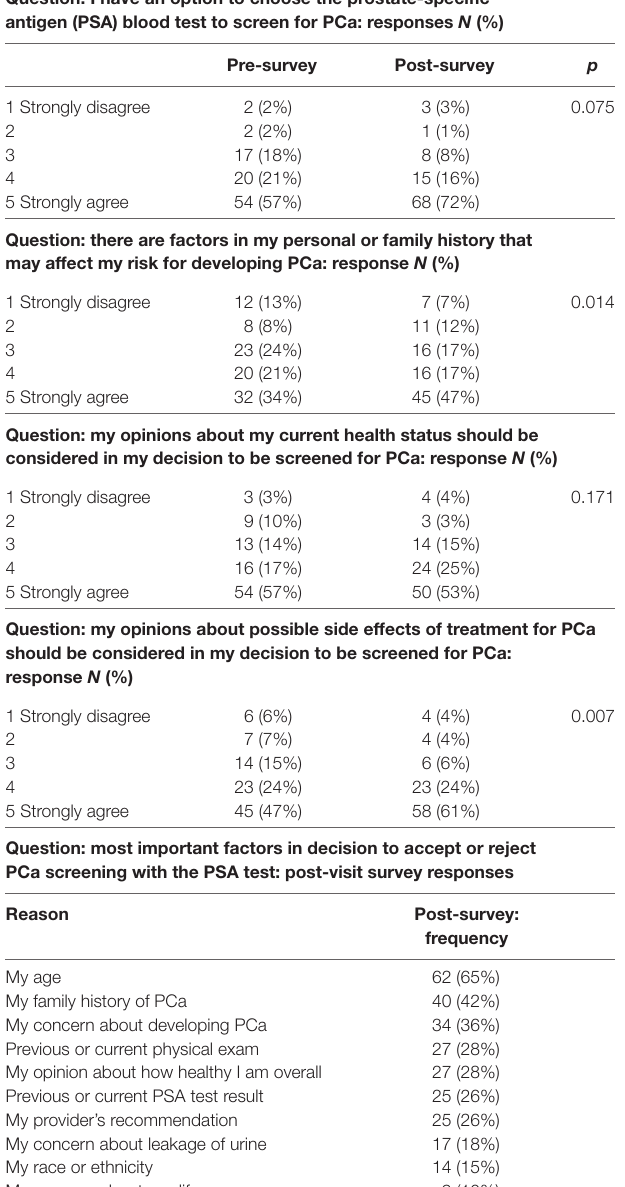
TaBle 1 | Survey responses with use of prostate cancer (PCa) screening conversation